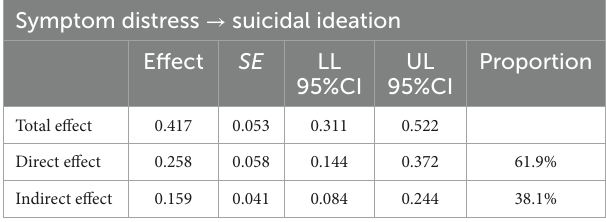
TABLE 4 Total effect, direct effect and mediating